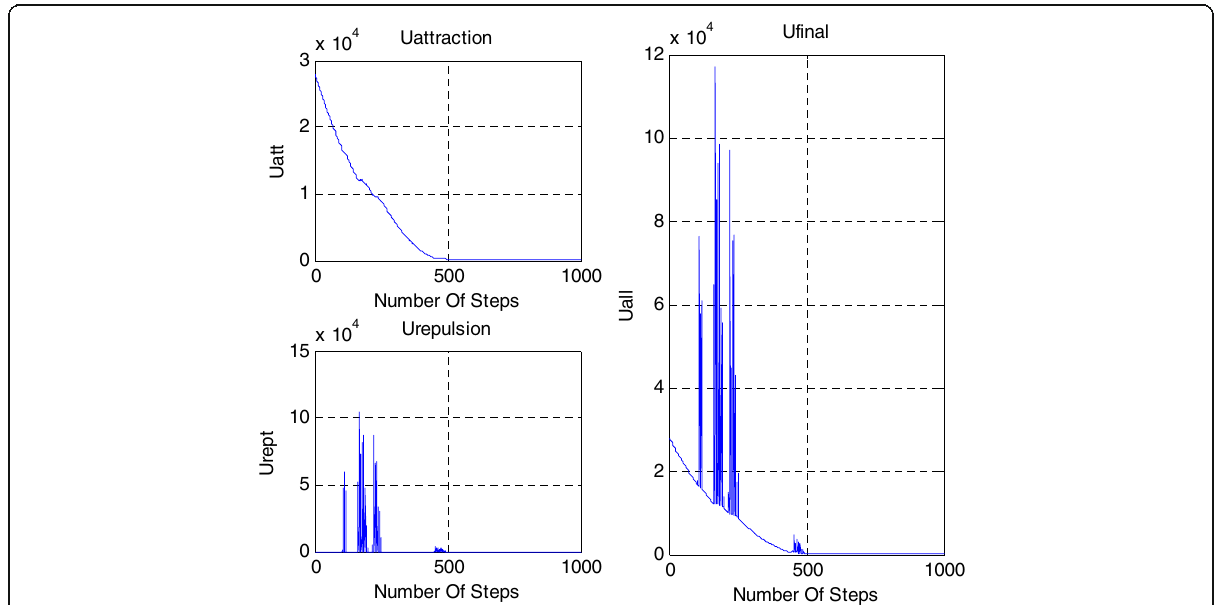
Fig. 18 The energy amount of repulsion and attraction and their yields according to the number of steps in the modified artificial potential field algorithm for circular obstacles with radius R =